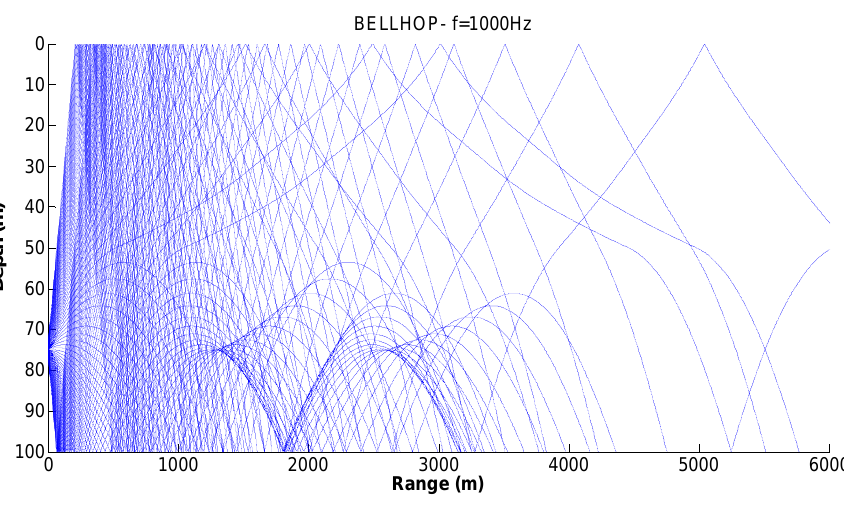
Figure 8. Corresponding ray trace for a source depth of 75 m.